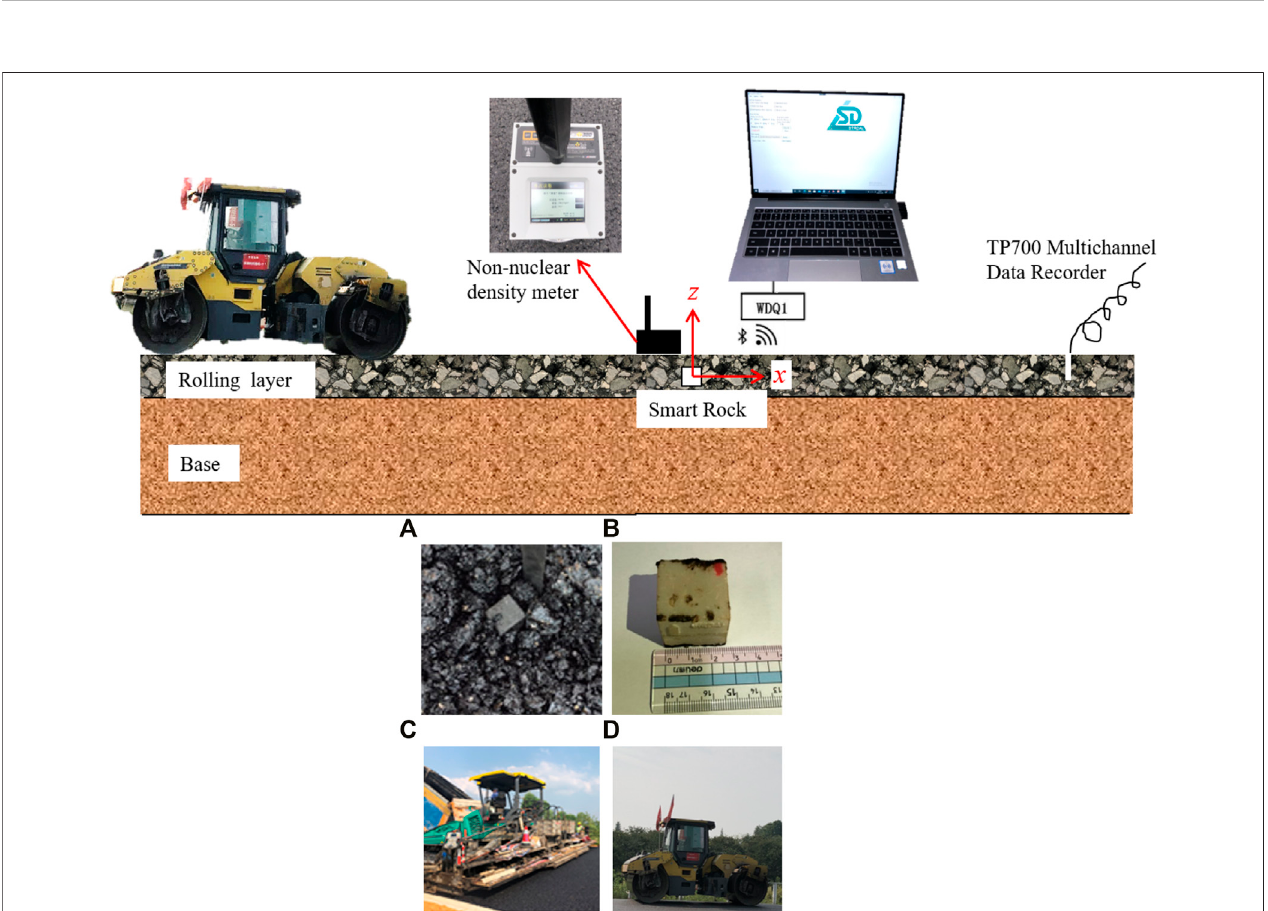
FIGURE4| Schematicdiagramofthe fi eldtestarrangementandsettinguptheSmartRock: (A) embedmentinmixture, (B) scaleofthesensor, (C) fi eldpaving,and (D) rolling.